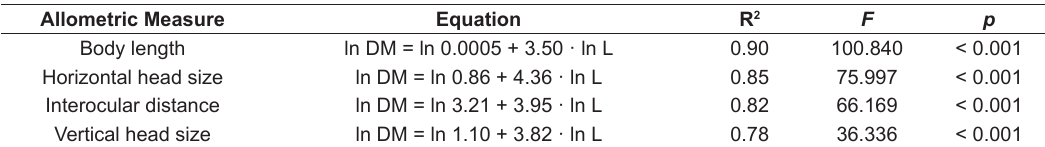
Table 2. Power function equations for length-mass body of Leptonema larvae and generalized linear model (GLM)